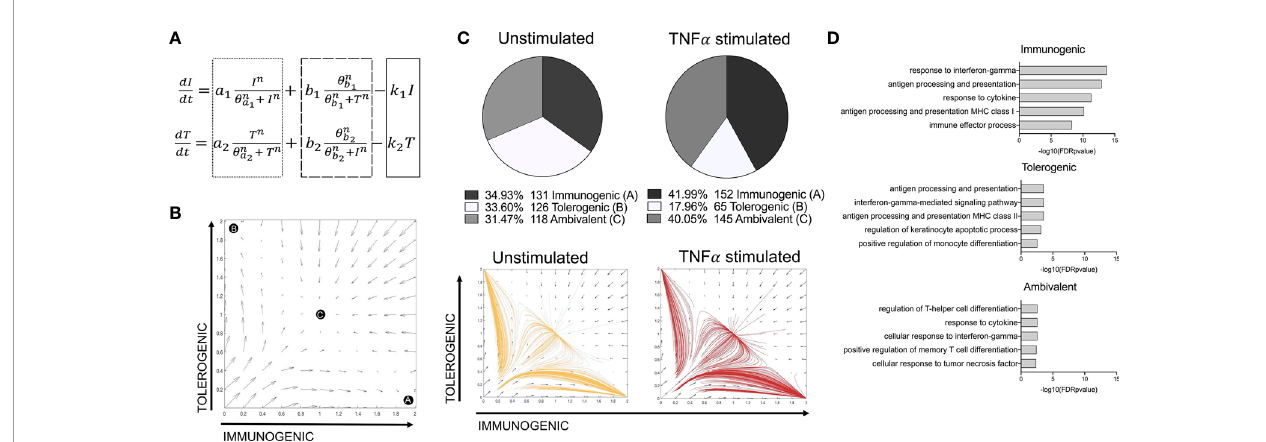
FIGURE 3 | A toggle switch mathematical model predicts immunogenic vs tolerogenic LC phenotypes from single cell transcriptomic data. (A) Dynamical system representing the activation of immunogenic (I) and tolerogenic (T) programmes in LCs. The dotted box represents terms describing the auto-ampli fi cation of each respective programme. The dashed box represents terms describing the cross-inhibition from opposing programmes, whilst the solid box depicts the fi rst-order decay rate (k) for each programme. (B) Phase portrait of the toggle switch model in which the two programmes (immunogenic and tolerogenic) auto-amplify their own expression and are mutually repressive. Black circles (A, B and C) represent end points for trajectories at stable attractors representing an immunogenic programme (A) , tolerogenic programme (B) or an ambivalent programme (C) . (C) Pie charts summarising the numbers and percentages of LC assigned to each phenotype through utilising the toggle-switch model for trajectory plotting. For each trajectory, representing an individual unstimulated or TNF-alpha-stimulated LC, the x-axis represents z-scores combining normalised IRF1/IRF4 expression values; the y-axis represents the z-scores combining SOX4, KRAS, IRF4 , RELB and ELK1 expression values. Z-scores were scaled to fi t phase portrait boundaries. (D) Gene ontology analysis (Toppgene) for top 100 genes expressed by immunogenic, tolerogenic and ambivalent LC (FDR corrected